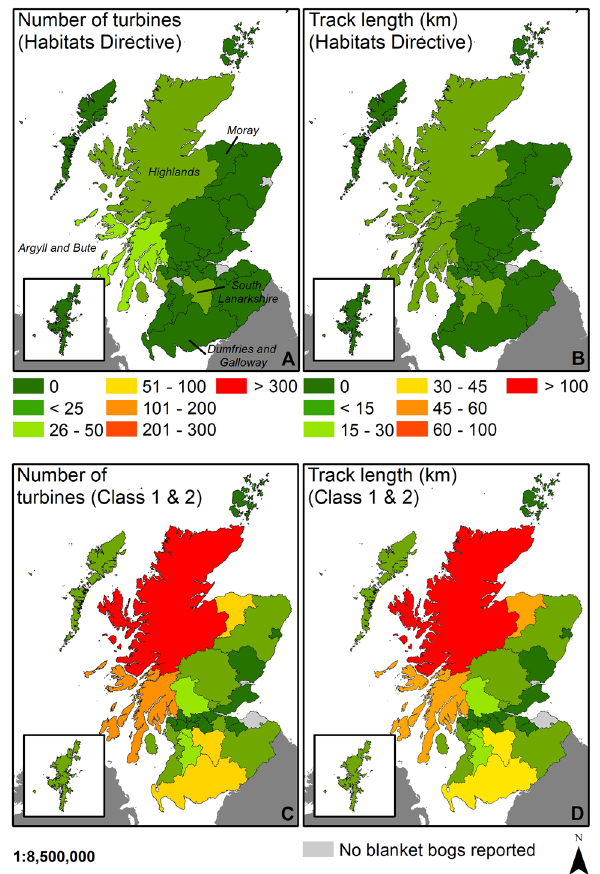
peat soils by country. ( D ) Tracks length on Class 1 & Class 2 peat soils by county. Dataset for blanket bog habitat 7130 : Scotland 33 . Dataset for Class 1 and Class 2 peat soils 39 . Map created in ArcGIS